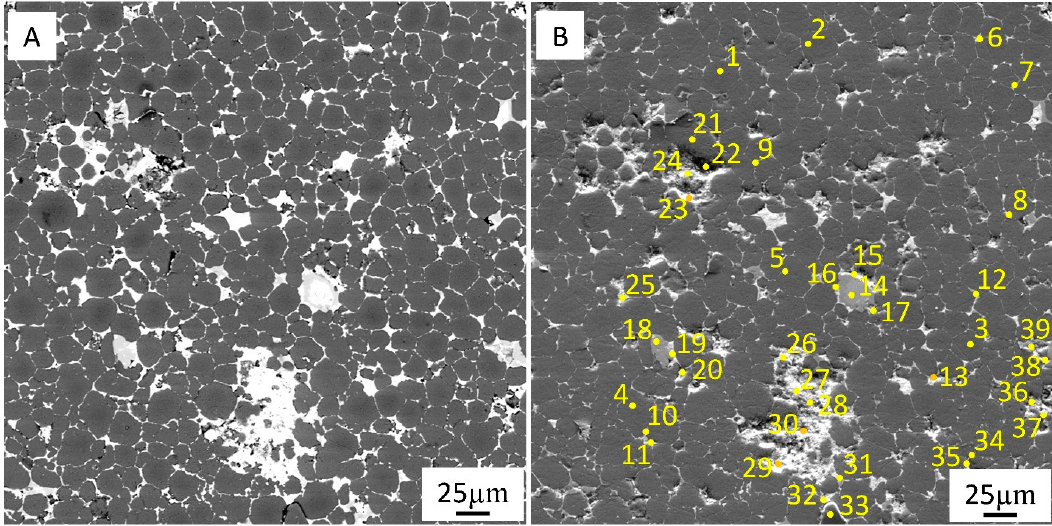
Figure 1. Backscattered electron (BSE) mode ( A ) and SE mode ( B ) with EDS analysis points SEM images of the M1 alloy.